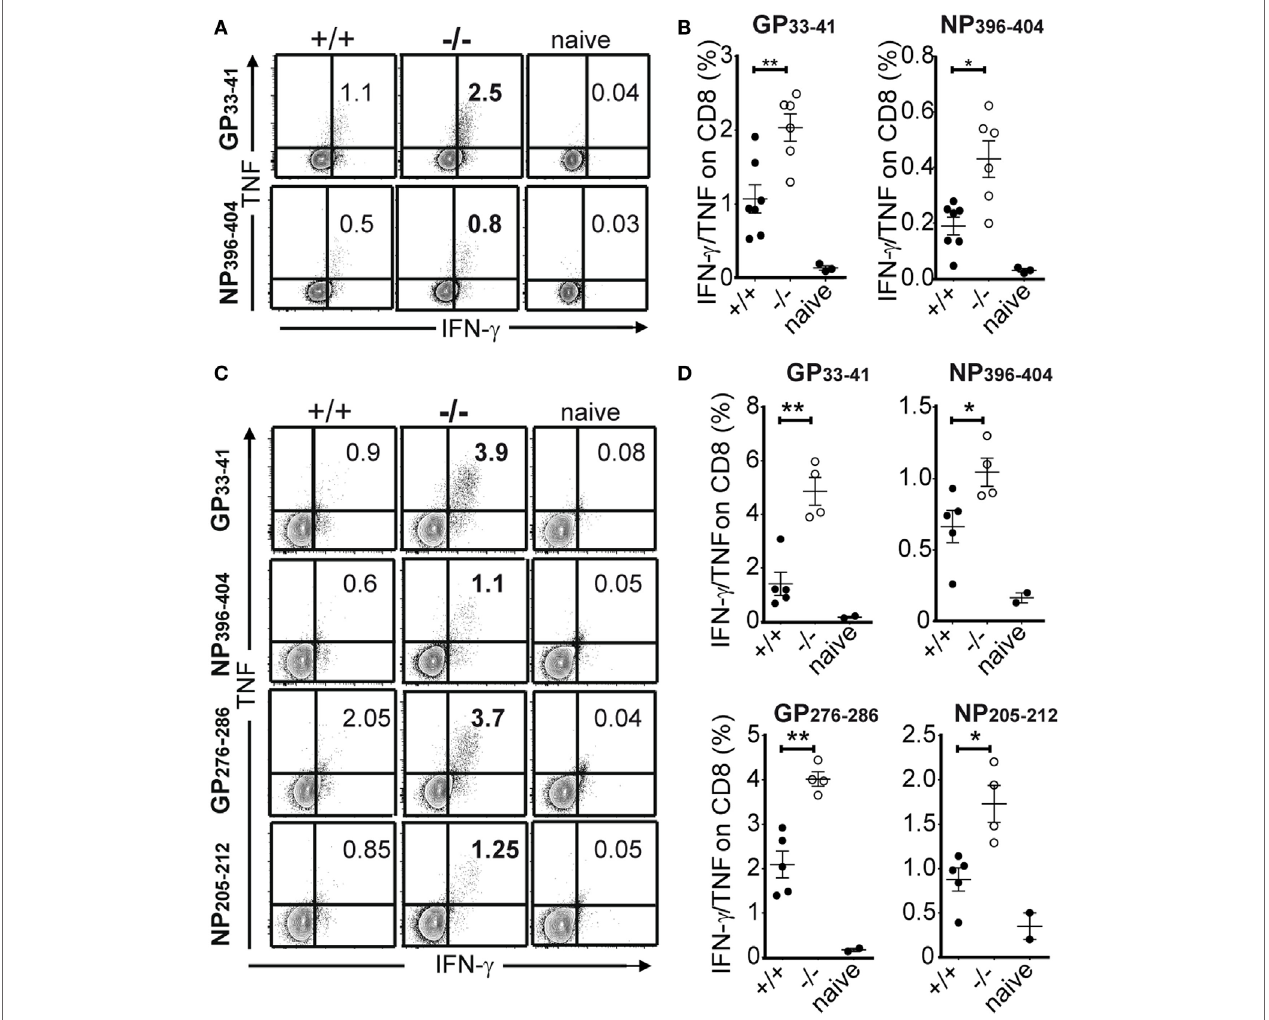
FigUre 3 | PTPN22 − / − mice show improved antiviral cytotoxic lymphocyte function. PTPN22 + / + (black circles) and PTPN22 − / − (white circles) mice were infected as described in Figure 1 . (a–D) intracellular cytokine staining was performed following in vitro stimulation with immunodominant CD8 epitopes at 8 (a,B) and 30 dpi (c,D) . IFN- γ /TNF- α double producing cells are depicted in the plots. Data are derived from a total of three independent experiments, one representative experiment is shown per graph. Number of symbols reflects number of mice per